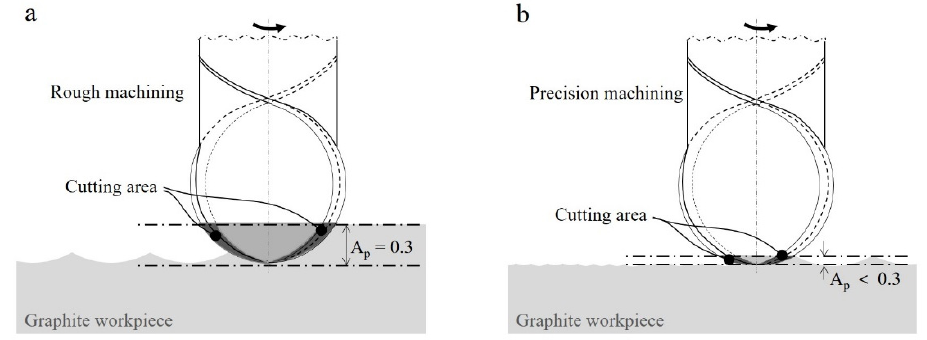
Figure 14. Area of tool edge participating in cutting during ( a ) rough and ( b ) precision machining.